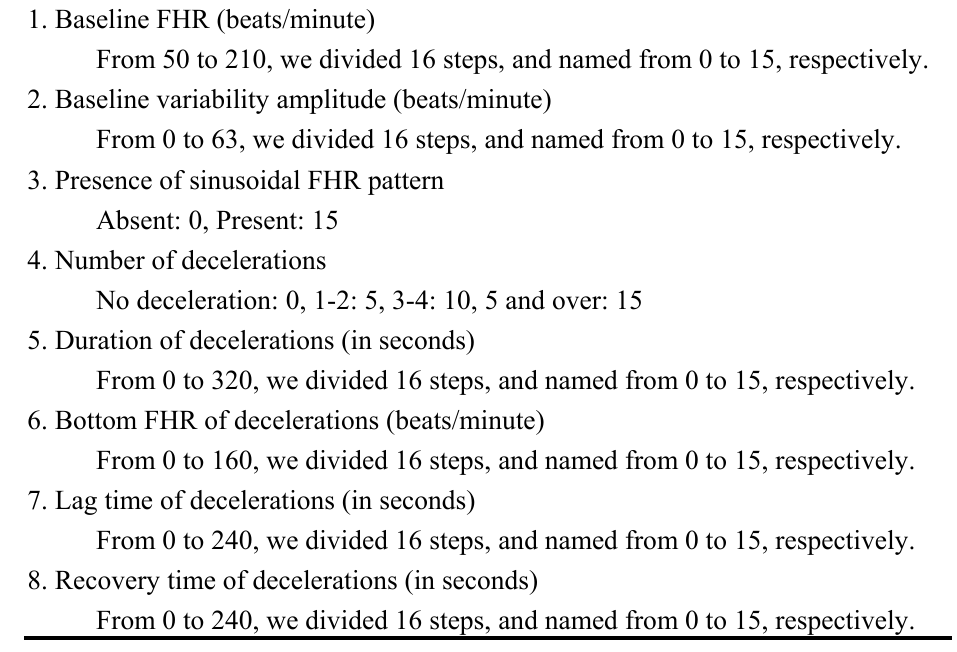
Table 2. Normalization of 16-step Coding Data